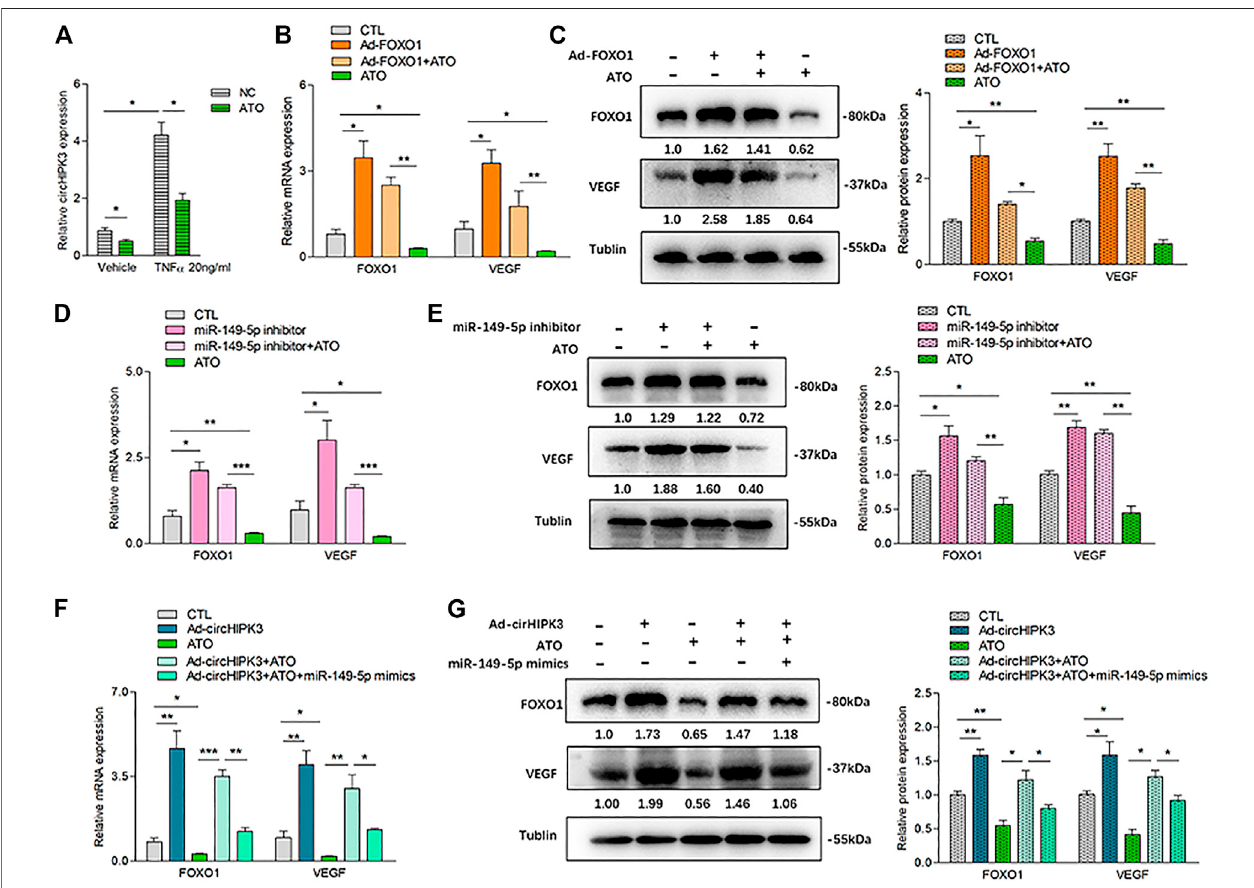
FIGURE 4 | ATO inhibited angiogenesis via modulating the circHIPK3/miR-149-5p/FOXO1/VEGF functional module in RA-FLS in vitro . (A) After RA-FLS were exposed to 50 ng/ml TNF- α and 2.0 µM ATO for 48h, the expression of circHIPK3 was upregulated by TNF- α induction, and this upregulation could be signi fi cantly suppressed by ATO treatment (n (cid:1) 3; * p < 0.05). (B – C) The expression of FOXO1/VEGF mRNA (B) and protein (C) were signi fi cantly upregulated by FOXO1 overexpressionanddownregulatedbyATO.Furthermore,theFOXO1/VEGFdownregulationinducedbyATOcouldberescuedpartiallybyFOXO1overexpression (n (cid:1) 3; * p < 0.05, ** p < 0.01). (D – E) The expression of FOXO1/VEGF mRNA (D) and protein (E) were signi fi cantly upregulated by miR-149-5p inhibitor, and downregulated by ATO. Additionally, the FOXO1/VEGF expression downregulated by ATO could be partially rescued by miR-149-5p inhibitor (n (cid:1) 3; * p < 0.05, ** p